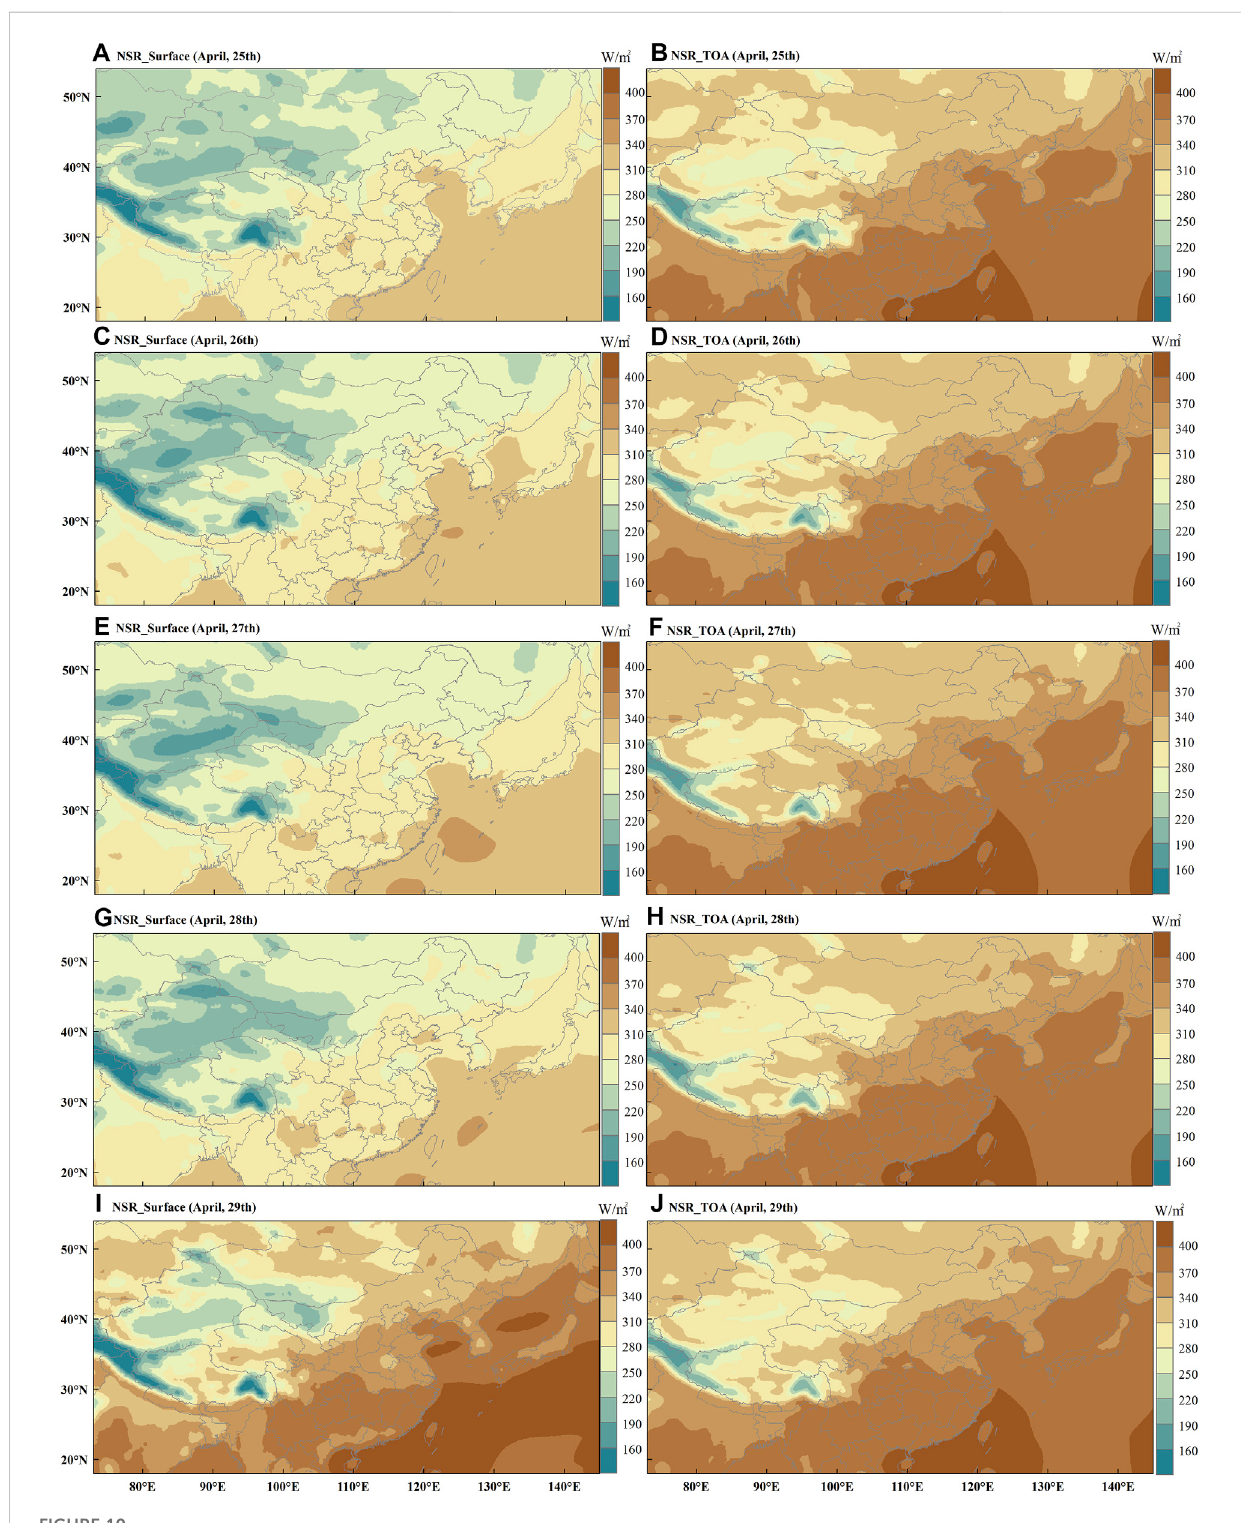
FIGURE 10 SpatialdistributionsofNSR SUR (A,C,E,G,andI) andNSR TOA (B,D,F,H,andJ) underthecloudlessconditionineasternAsiaduringApril25 –